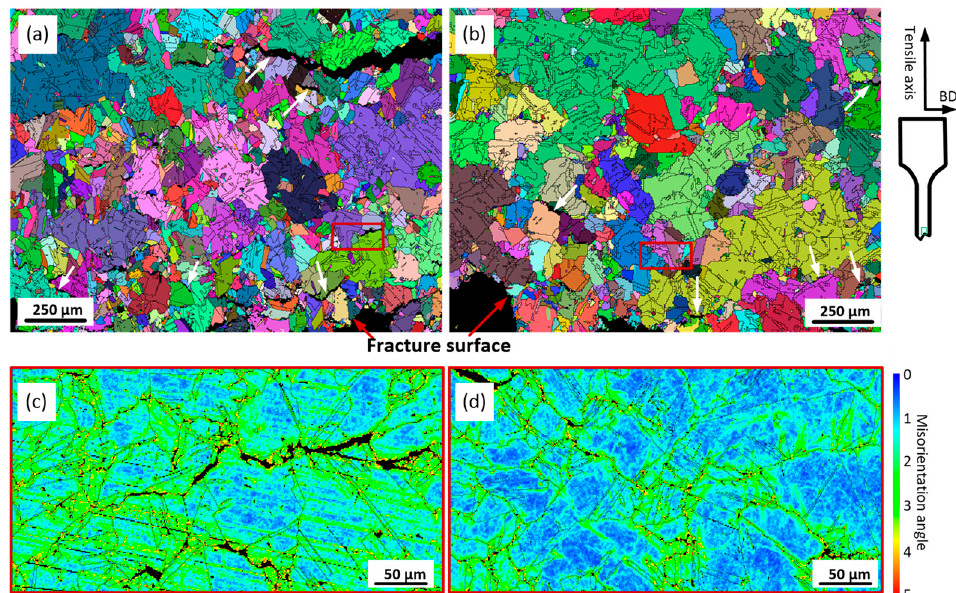
Figure 13. Grains under the fracture surfaces (longitudinal cross section) of ( a ) ST Alloy 1 and ( b ) ST Alloy 2 after tensile testing at 760 °C (white arrows indicate microcracks); KAM maps for selected area of ( c ) ST Alloy 1 and ( d ) ST Alloy 2.